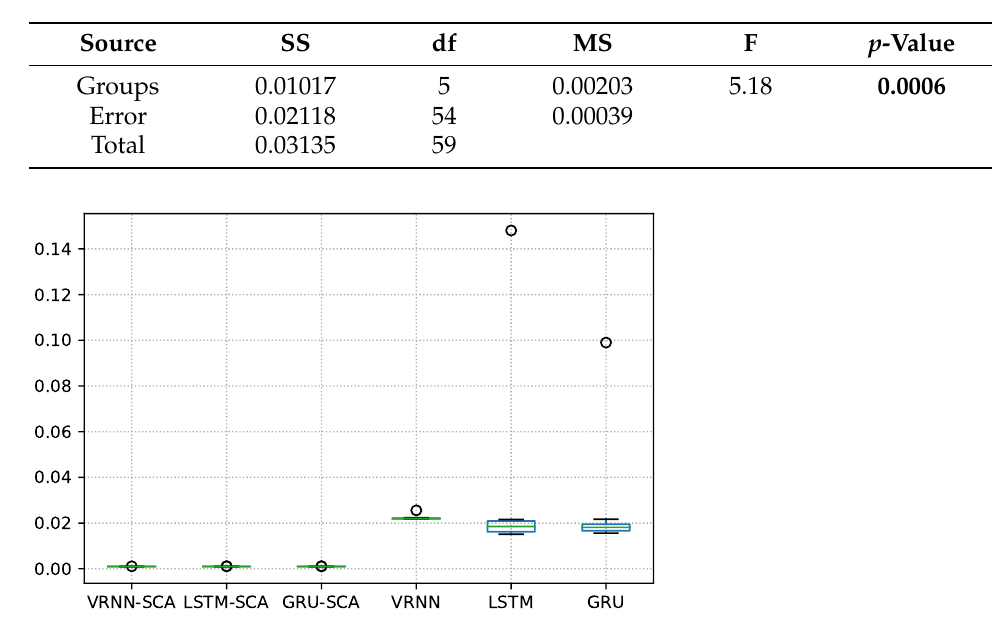
Figure 17. Boxplot differences on the 41043 dataset. Table 17. ANOVA table results on dataset 41060.